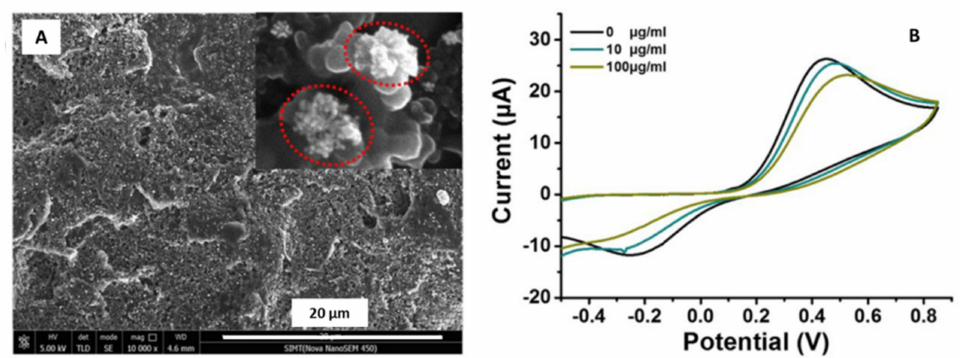
Figure 8. ( A ) SEM micrograph of gold nanoflowers deposited onto the Screen Printed Carbon Electrode (SPCE). ( B ) Cyclic voltammograms obtained for the modified electrode detecting HbA1c in 2.5 mM K 4 Fe(CN) 6 containing 0.1 M KCl. Reproduced with permission Wang et al., Talanta; published by Elsevier, 2019